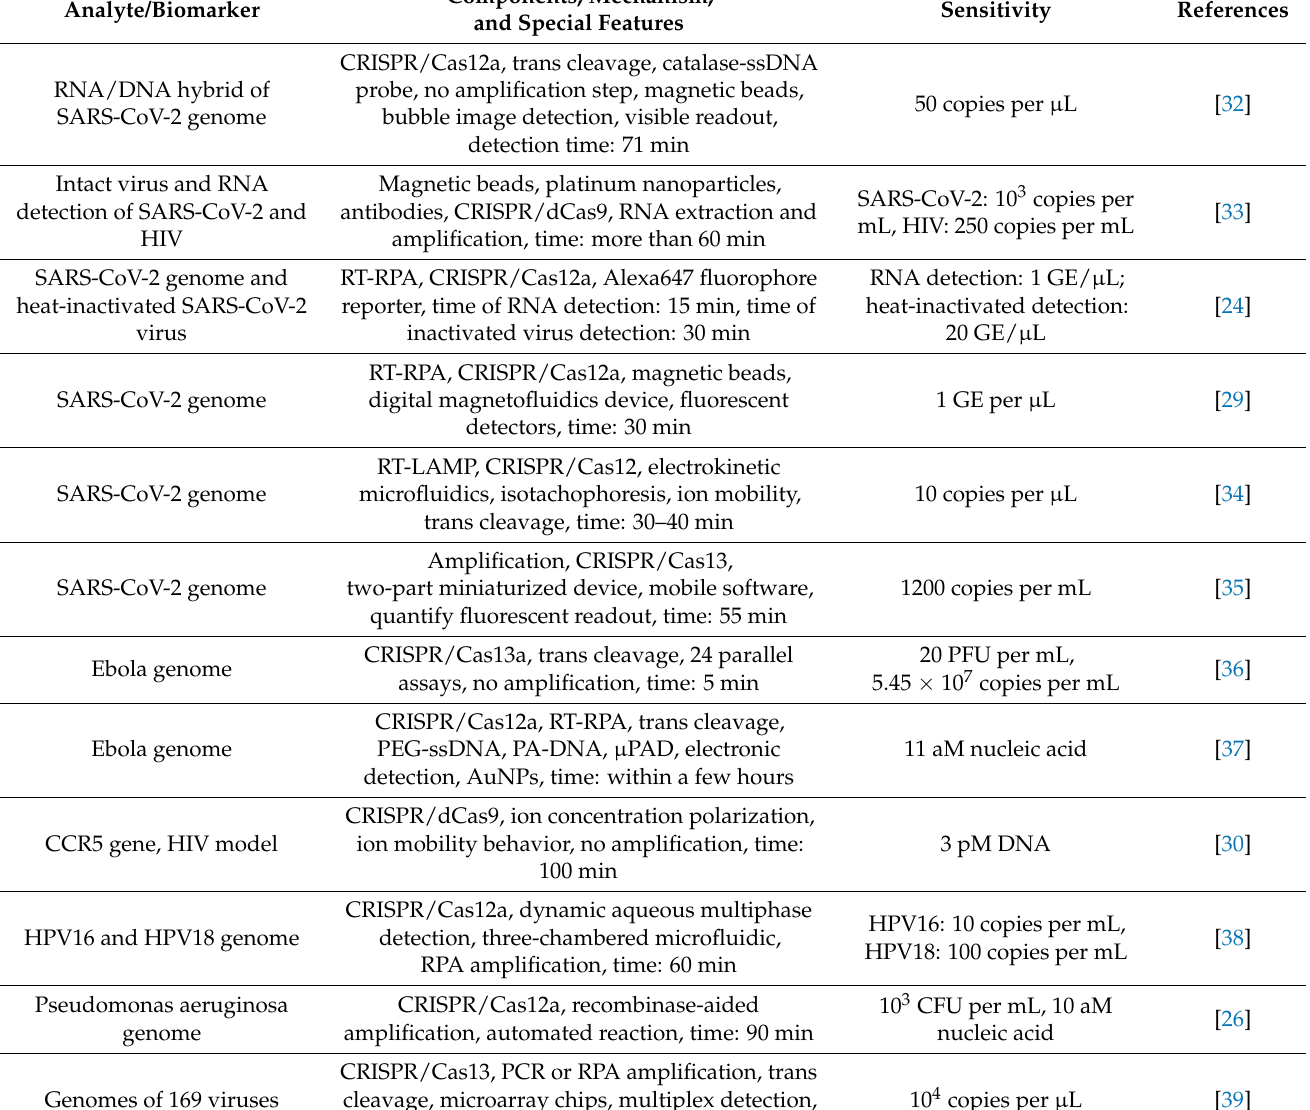
Table 1. The summary of recent CRISPR-powered microfluidic biosensors and their specifications. Components, Mechanism, Analyte/Biomarker and Special Features